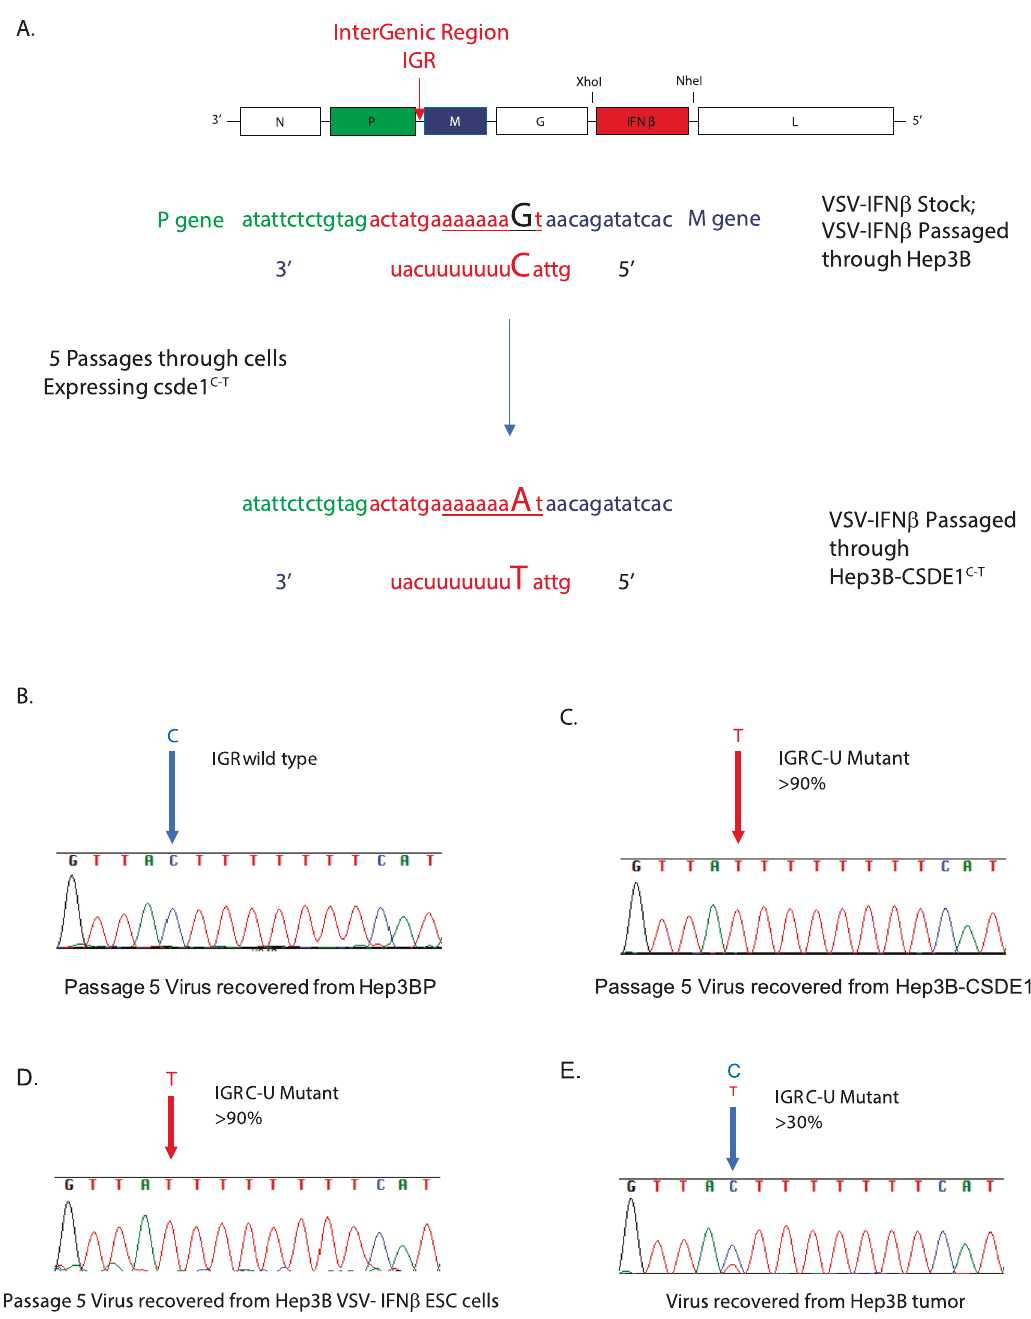
Fig. 2 Forced evolution of VSV selects a single point mutation in the P/M IGR. VSV-IFN β was passaged 5× through Hep3B or Hep3B-CSDE1 C-T cells as in Fig. 1. Sanger sequence of the IGR between the P and M genes ( A ) from virus populations passaged through B Hep3B parental cells showed homogenous populations of wild-type sequence; sequence of viruses passaged through either C Hep3B-CSDE1 C-T cells or D Hep3B-VSV-IFN β − 21d ESC cells were largely homogenous for a point mutation C – U. Representative of fi ve separate experiments. E Virus population from a Hep3B tumor grown in a SCID mouse and excised upon recurrence following treatment with VSV-IFN β was a heterogenous population of wild-type and mutant IGR P/M viruses. Representative of two separate escape